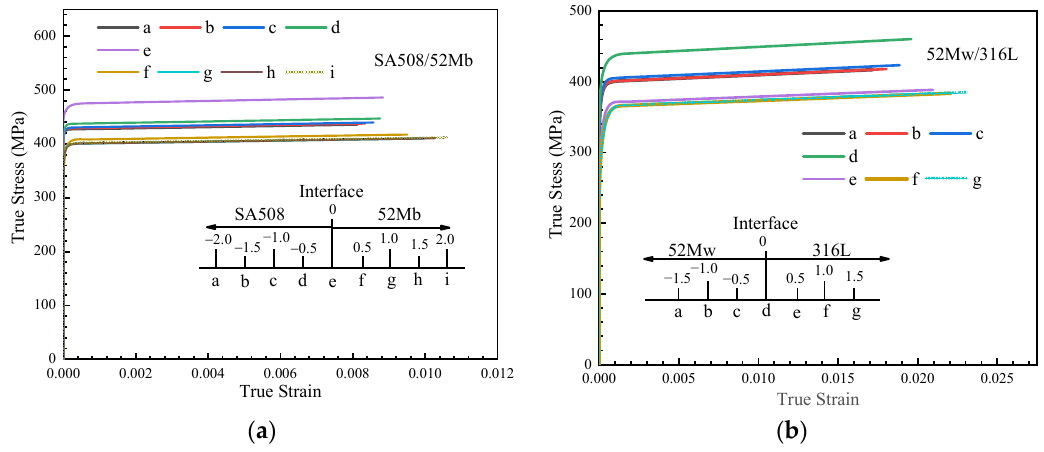
Figure 8. Stress–strain curves at the ( a ) SA508/52Mb and ( b ) 52Mw/316L interface zones.